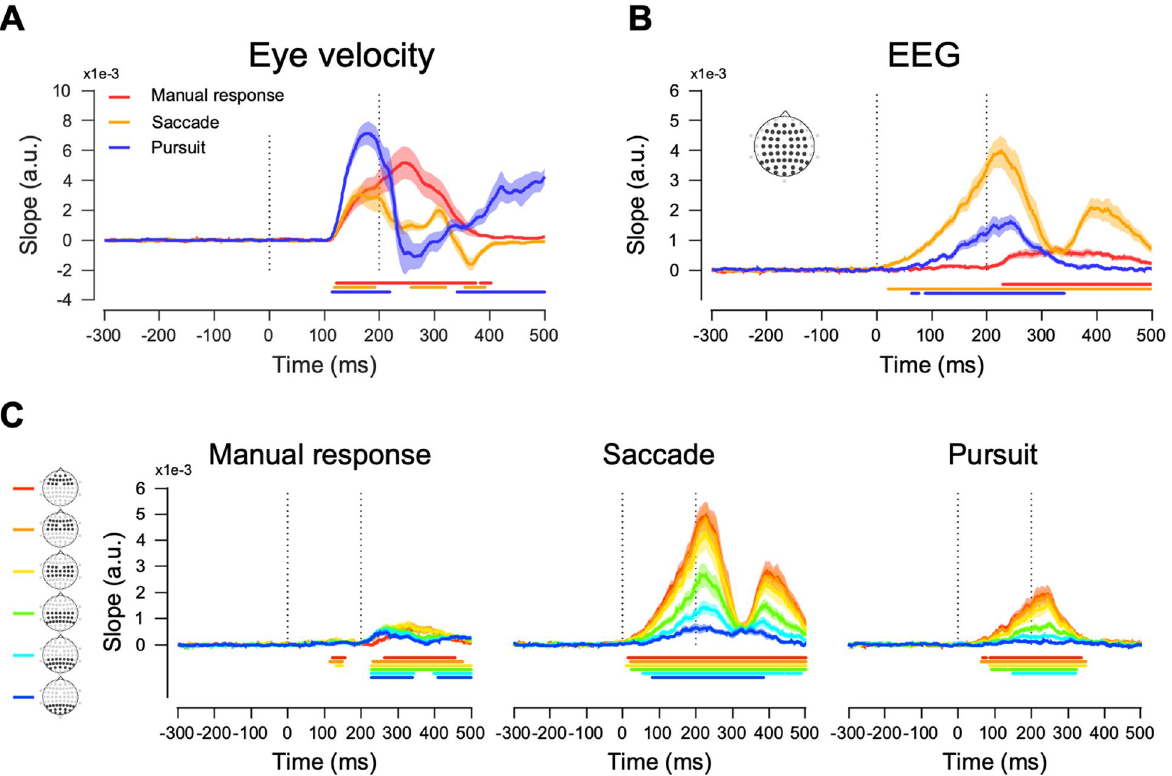
Figure 4. Behavioral and neural direction discrimination. Indices for direction discrimination were estimated from the linear regression analysis for ( A ) Eye velocity, ( B ) EEG data, and ( C ) EEG data divided into six groups of channels. The motion period was marked with vertical dotted lines, and shaded regions denote the standard errors. Colored lines under each plot denote the time clusters that were significantly different from the baseline (two-sided cluster-based permutation test, p <